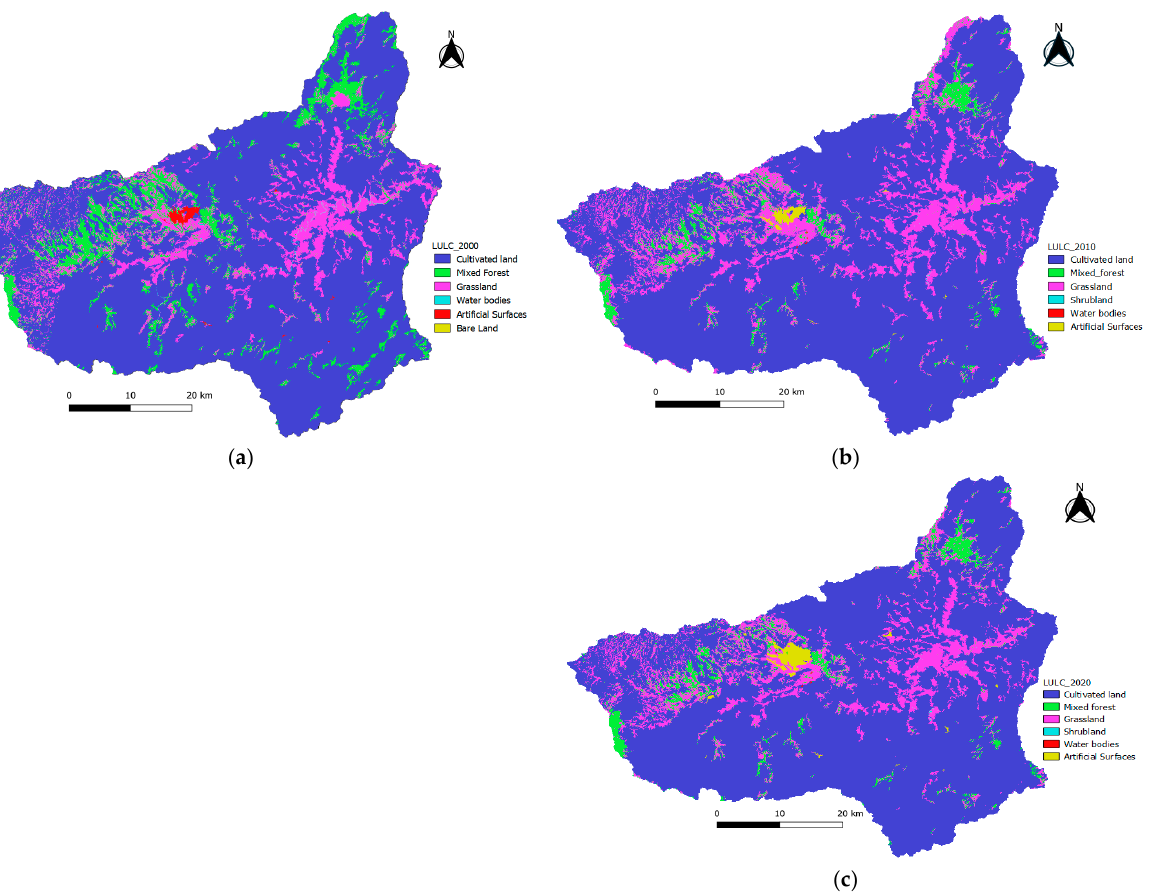
Figure 2. The study area LULC maps of ( a ) 2000, ( b ) 2010, ( c ) 2020.